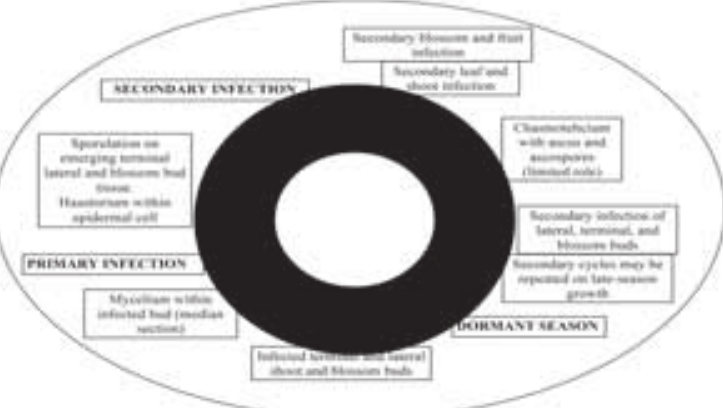
Figure 1: Disease cycle of Podosphaera